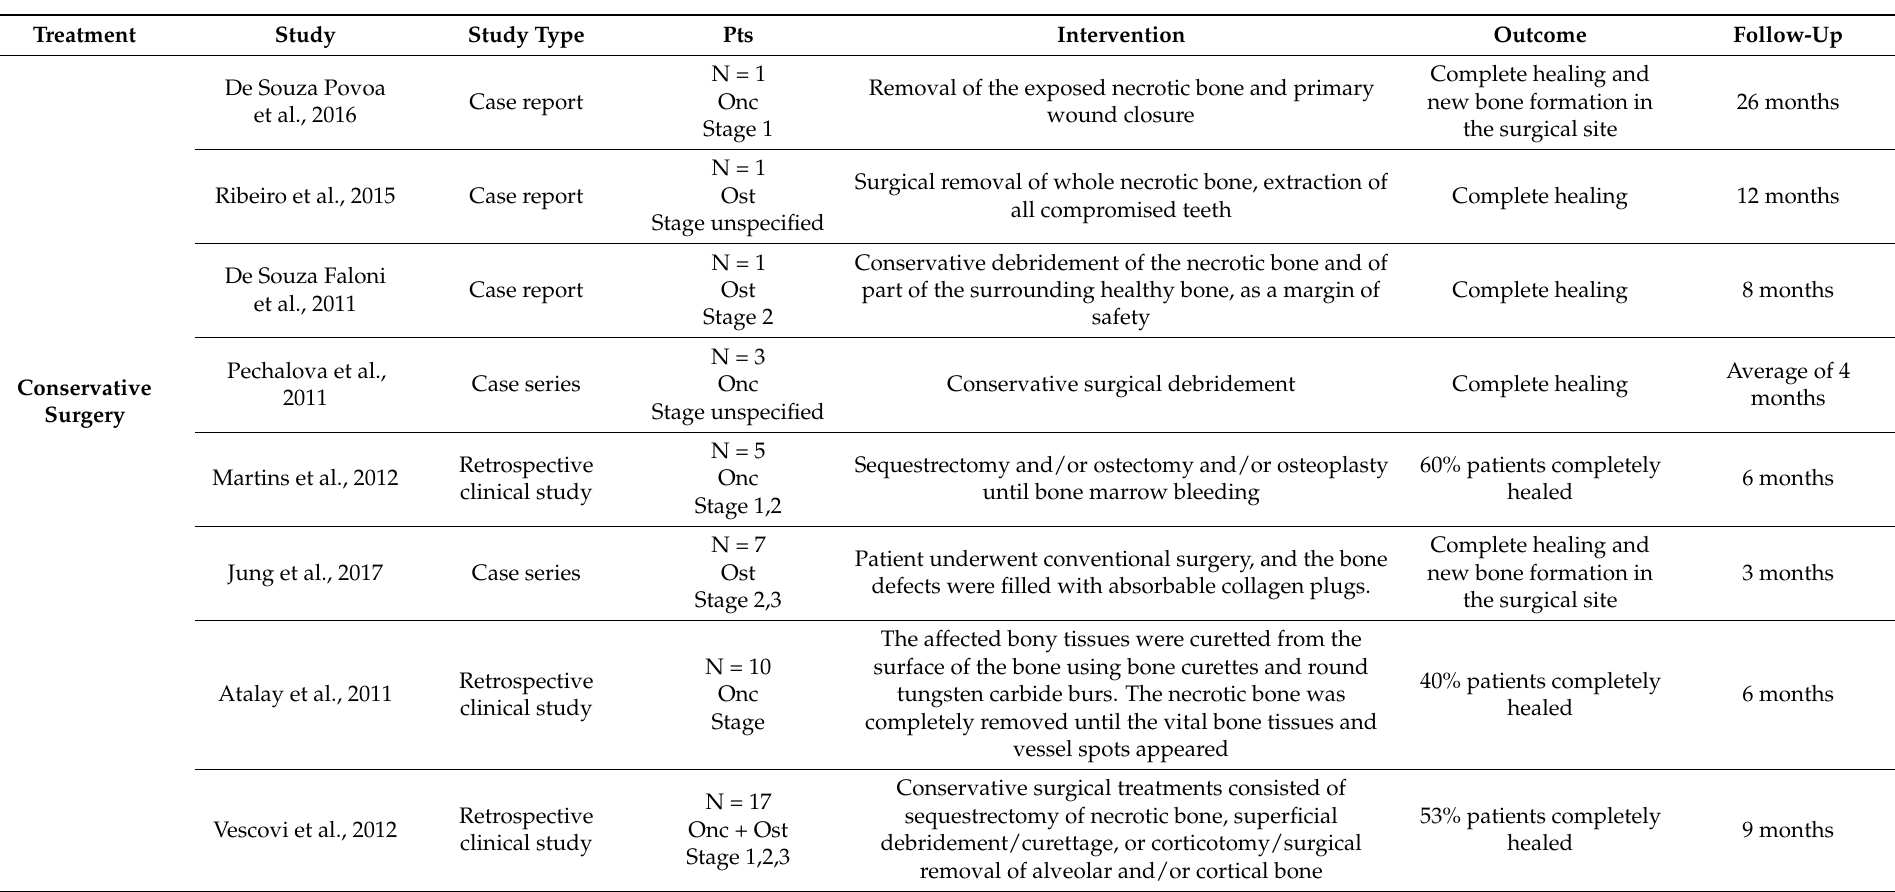
Table 2. Summary of the characteristics and the results of the studies concerning MRONJ surgical